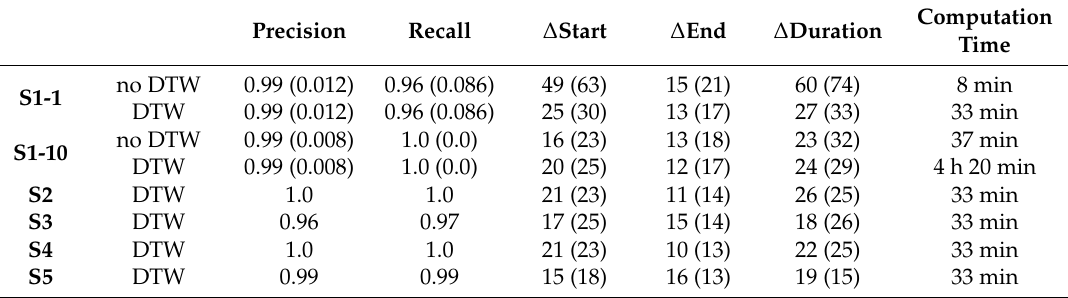
Table 3. Evaluation metrics obtained by strategies S1, S2, S3, S4 and S5. For S1-1 and S1-10, the precision and recall are averaged on the whole database and on 20 independent simulations (means and standard deviations). ∆ Start, ∆ End and ∆ Duration are displayed in milliseconds and averaged on the whole database (means and standard deviations). Computation time corresponds to the time to process the whole